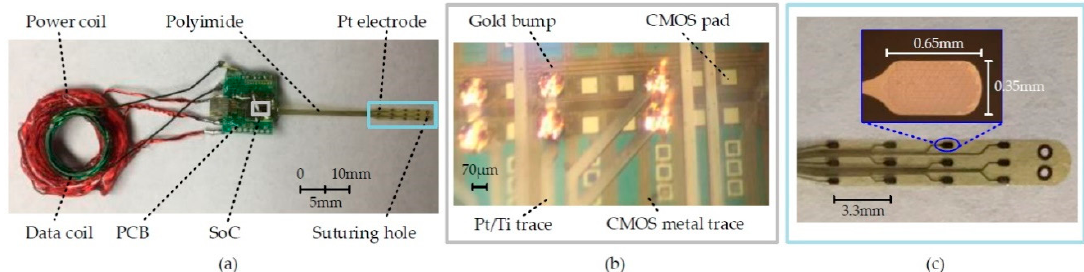
Figure 4. ( a ) Photo of EGMD prototype for chronic study. Zoom-in view of ( b ) system on a chip (SoC) part under microscope and ( c ) electrode